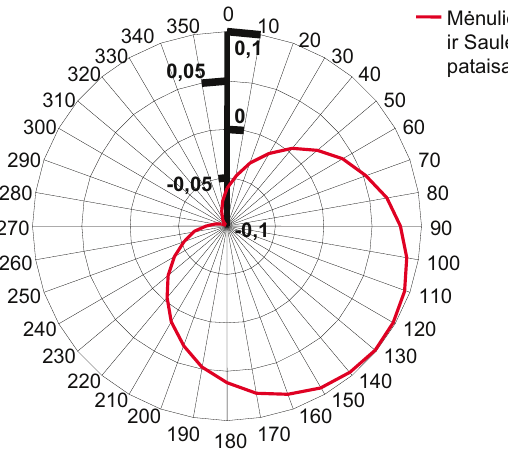
Fig. 3. Correction dependency on azimuth change